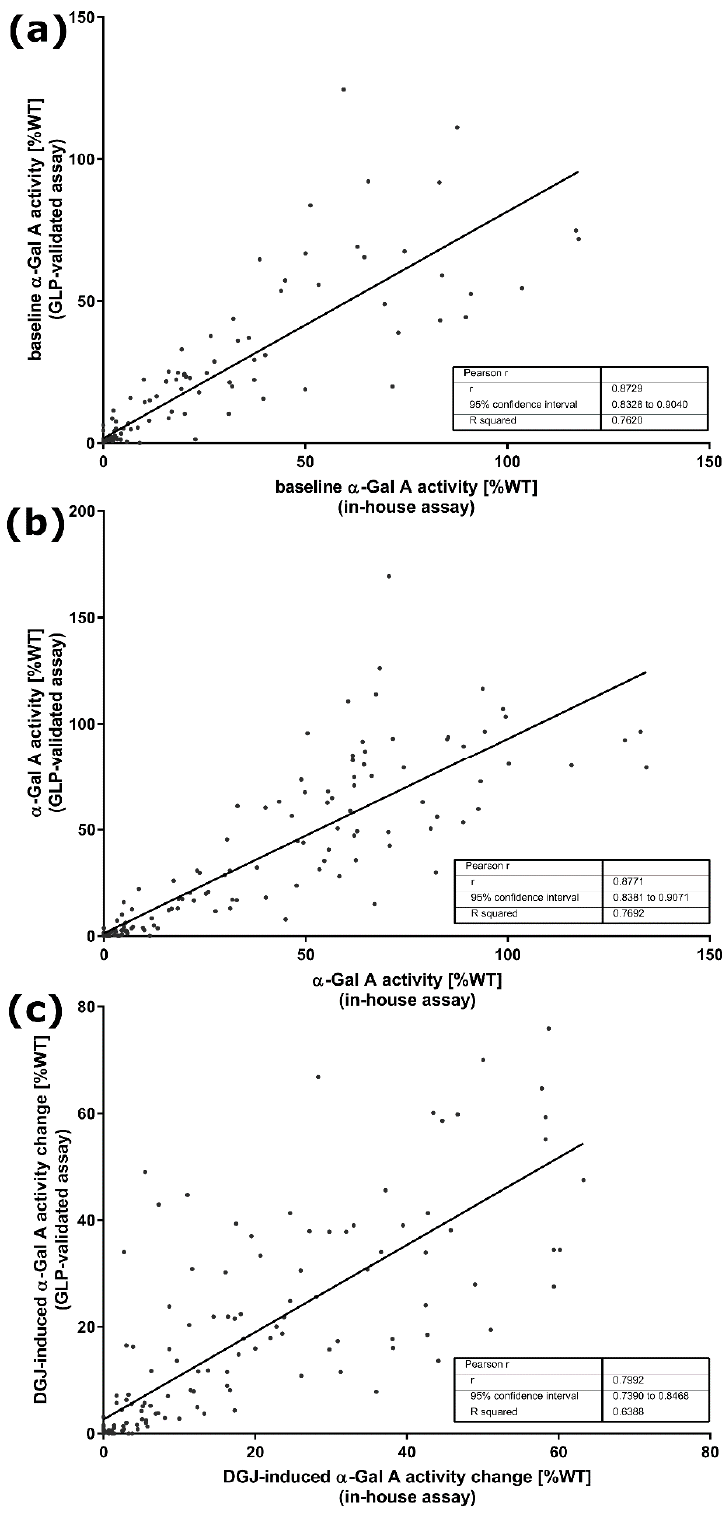
Figure 1. Linear correlation analysis of α -galactosidase A ( α -Gal A) activity presented as absolute increase (%WT) of GLA variants ( a ) without and ( b ) with DGJ between the in-house assay and the GLP-validated assay. ( c ) Linear correlation analysis of DGJ-induced α -Gal A activity change over baseline (%WT) of the GLA variants.